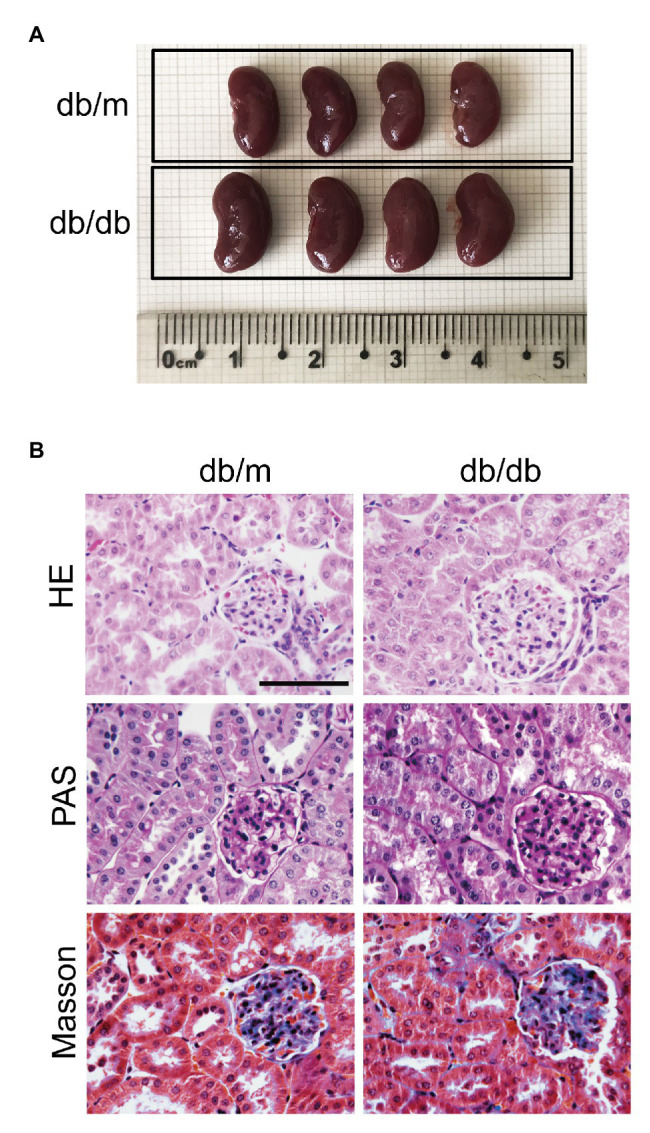
Renal histopathological changes in experimental mice at 16 weeks. (A) Representative images of whole kidneys from db/m and db/db mice. The scale bar is located on the image, and units are cm. (B) Representative images of kidney sections stained with HE, PAS, and Masson’s trichrome. Original magnification = 400. Scale bar = 100 μm.